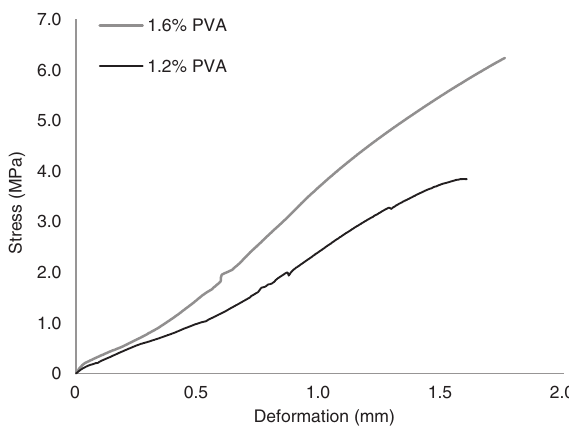
Figure 9 Longitudinal sample tensile behavior.